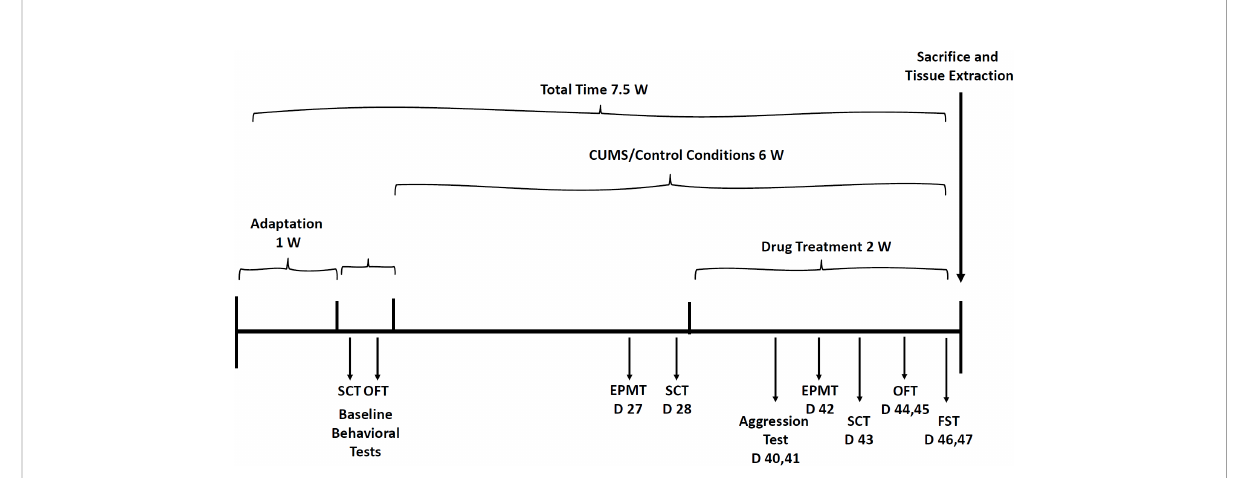
FIGURE 2 Timeline for behavioral experiments. Before initiation of the CUMS protocol, baseline SCT and OFT were performed. Then, rats were subjected to CUMS or control conditions for six weeks during the last two weeks of which, they were treated with MTK (or vehicle). The various behavioral tests were performed on different days of the experiment as illustrated in the fi gure. CUMS, chronic unpredictable mild stress; D, day; EPMT, elevated plus-maze test; FST, forced swim test; OFT, open fi eld test; SCT, sucrose consumption test; W,